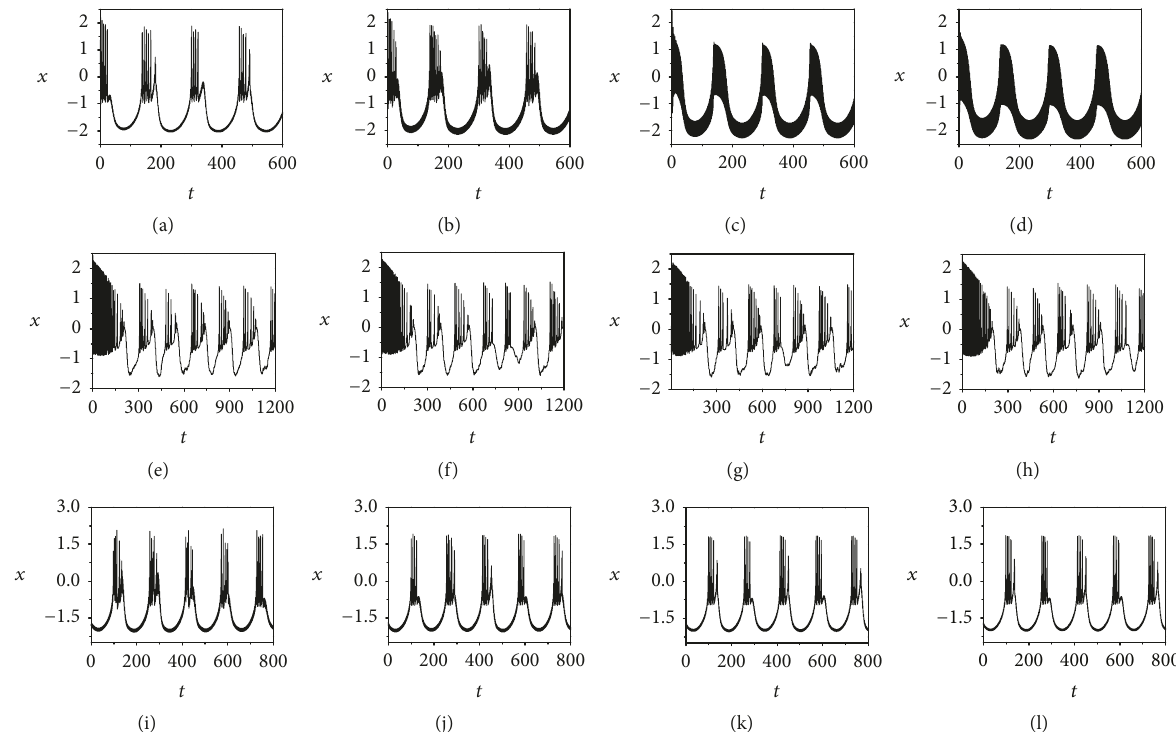
Figure 8: Sampled time series of membrane potential under different parameters. In the first layer, 𝐴 = 1.6 , 𝜔 = 0.04 , 𝑁 = 200 , (a) 𝐵 = 0.9 , (b) 𝐵 = 3.0 , (c) 𝐵 = 7.2 , and (d) 𝐵 = 9.0 . In the second layer, 𝐴 = 1.6 , 𝐵 = 1.6 , 𝑁 = 200 , (e) 𝜔 = 0.001 , (f) 𝜔 = 0.01 , (g) 𝜔 = 0.04 , and (h) 𝜔 = 0.2 . In the last layer, 𝐴 = 1.6 , 𝐵 = 1.6 , 𝜔 = 0.04 , (i) 𝑁 = 100 , (j) 𝑁 = 300 , (k) 𝑁 = 700 , and (l) 𝑁 = 900 . The Gaussian white noise intensity 𝐷 = 0.2 , and the external high-low frequency current is set as 𝐼 ext = 𝐴 cos (𝜔𝑡) + 𝐵 cos (𝑁𝜔𝑡)